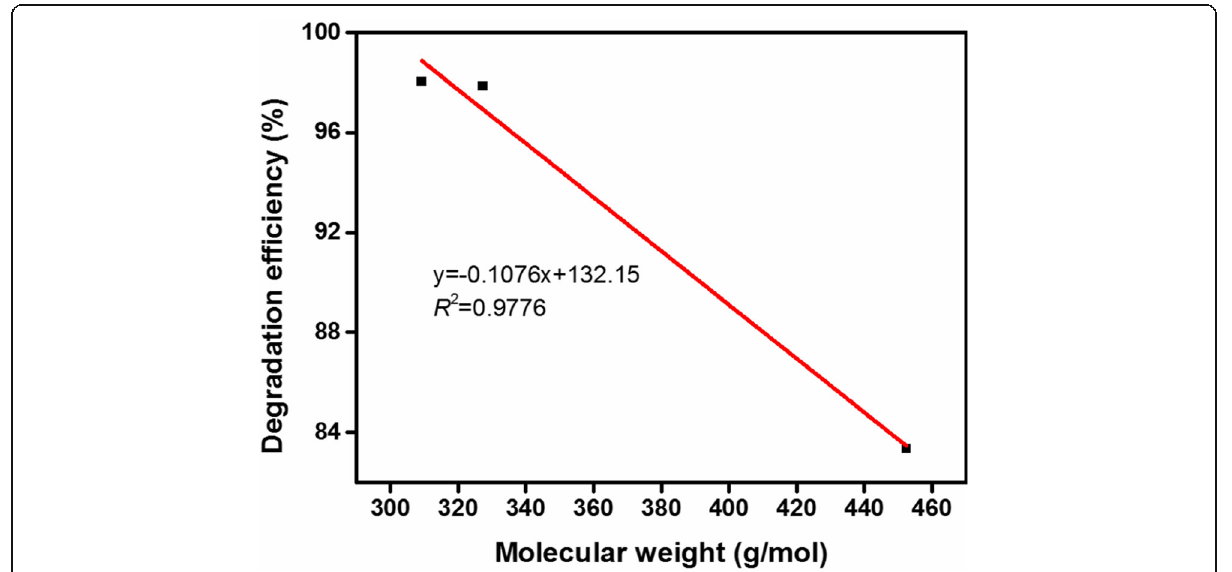
Fig. 12 Correlation between molecular weight of azo dye and degradation